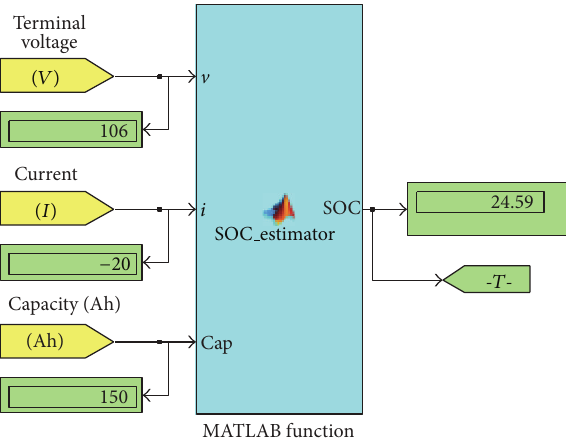
Figure 18: Embedded controller based SOC